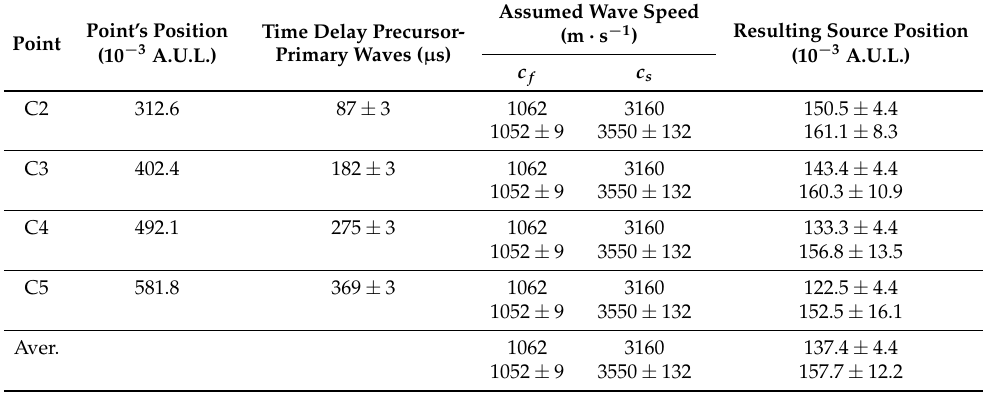
Table 5. Single-sensor localization with points in the main section—results (actual source position: 135.3 × 10 − 3